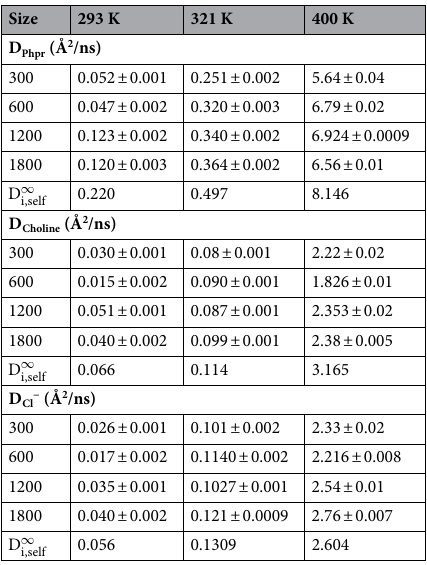
Table 6. The self- diffusion coefficient (Å 2 /ns) of chloride anion, choline cation and phenyl propionic acid molecules (Phpr) obtaine from MD simulations for different size DES system and thermodynamic limit ( D ∞ i,self ) at 293, 321 and 400 K and 0.1